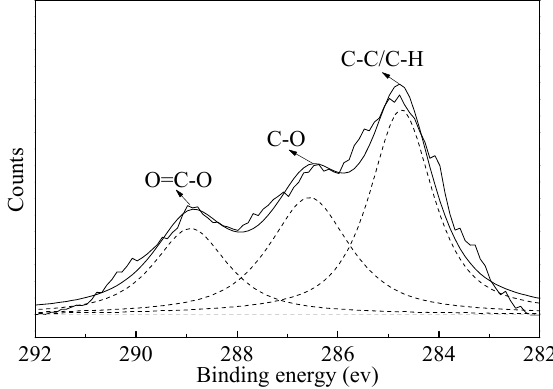
Figure 13. C1 XPS of the flocculated initial concentrate. Minerals 2016 , 6 , 86